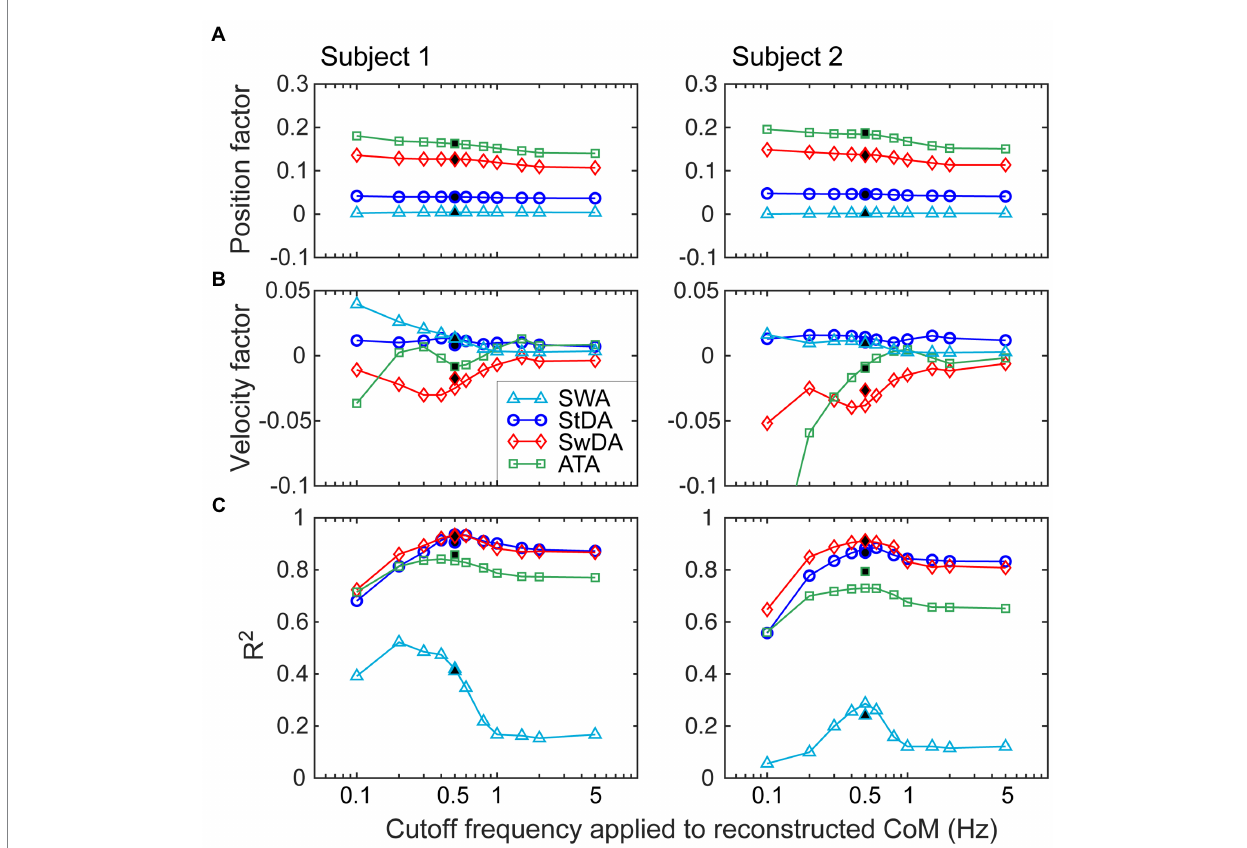
FIGURE 10 Investigation of the effects of the choice of the cutoff frequency of a lowpass filter applied to CoM stimulus-evoked motion on the calculation of position (A) and velocity (B) regression factors that relate CoM motion to asymmetry measures. Data from two different subjects are shown from eyes- closed, metronome-paced tests with 3 ° peak-to-peak surface-tilt stimuli. Lowpass filtering with cutoff frequencies ranging from 0.1 to 5 Hz was applied to the separated stimulus-evoked CoM sway (see Figure 9) before performing regression analysis to calculate CoM angular position and velocity factors. (C) R 2 values indicating the variance accounted for by the regression analysis varied with the cutoff frequency. Filled points at 0.5 Hz are from the normal analysis that did not use the separated stimulus-evoked CoM